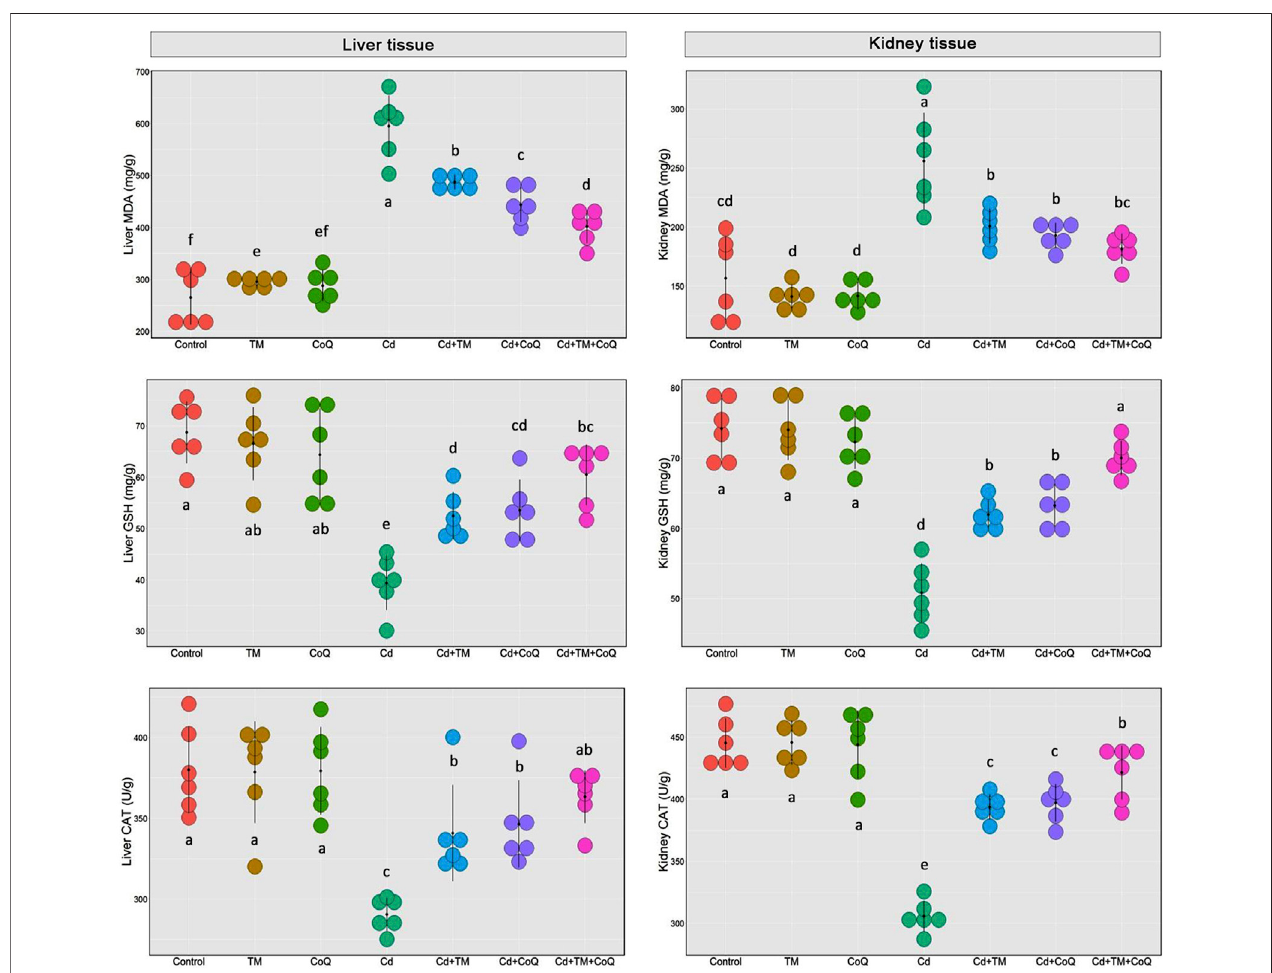
FIGURE 4 | Dot plot of oxidative/antioxidative state following Cd, TM, and CoQ treatment. CAT, catalase; Cd, cadmium; CoQ, coenzyme Q10; GSH, reduced glutathione; MDA, malondialdehyde; TM, Tamarindus indica . Data are presented as mean ± SD ( n = 6).